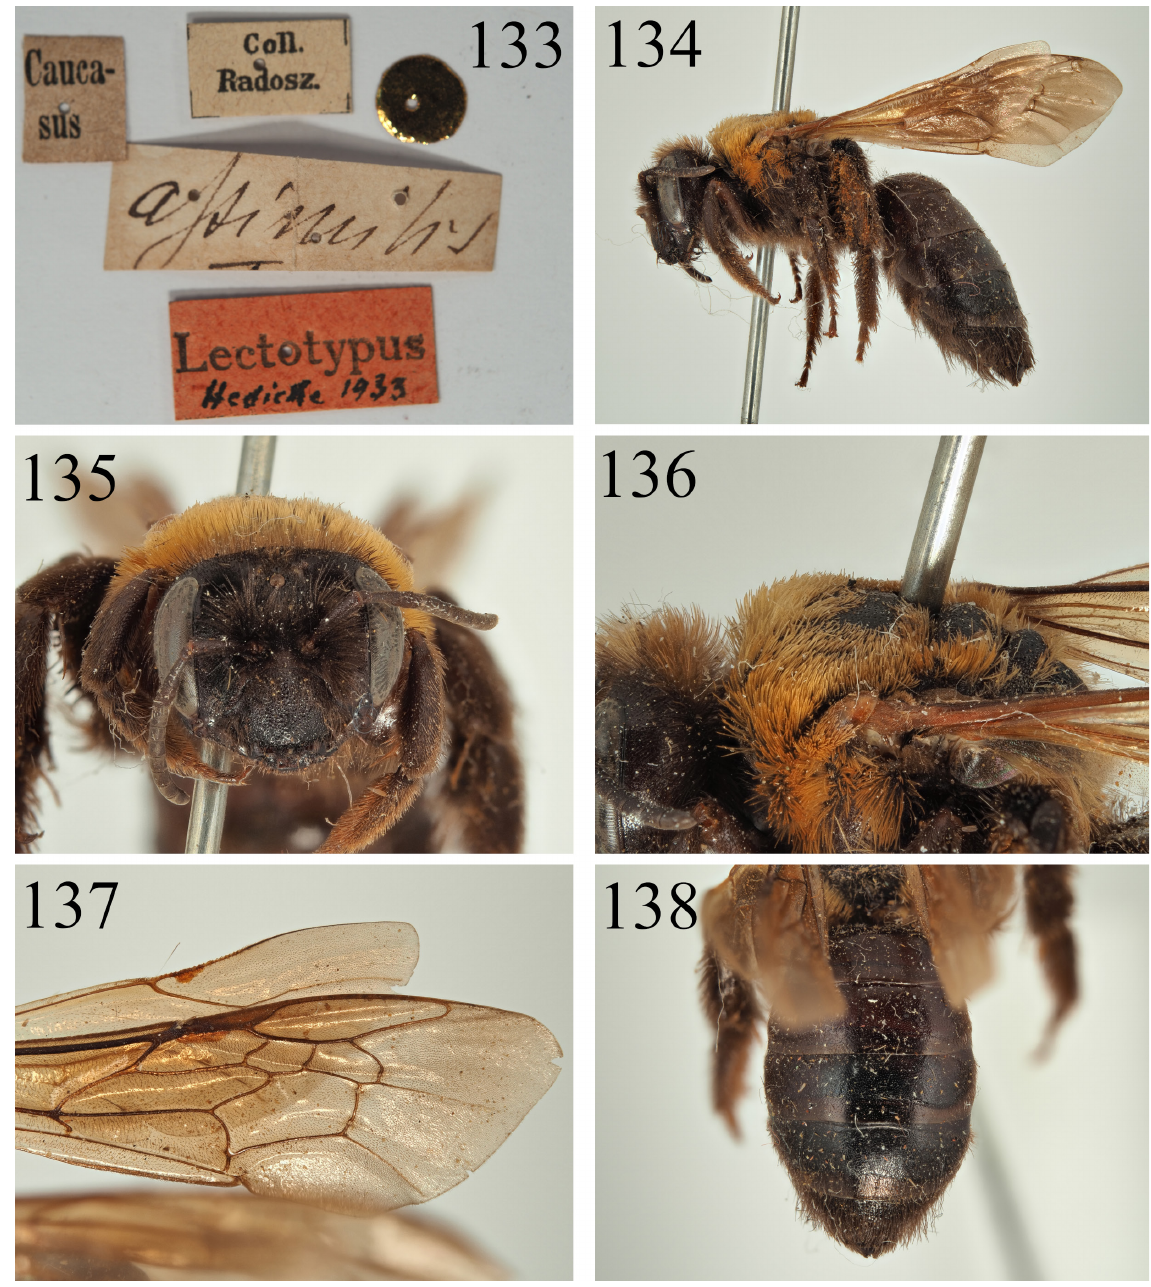
Figs 133–138. Andrena assimilis Radoszkowski, 1876, ♀, lectotype (ZMHB). 133 . Label, detail. 134 . Profile. 135 . Face. 136 . Scutum, detail. 137 . Wing, detail. 138